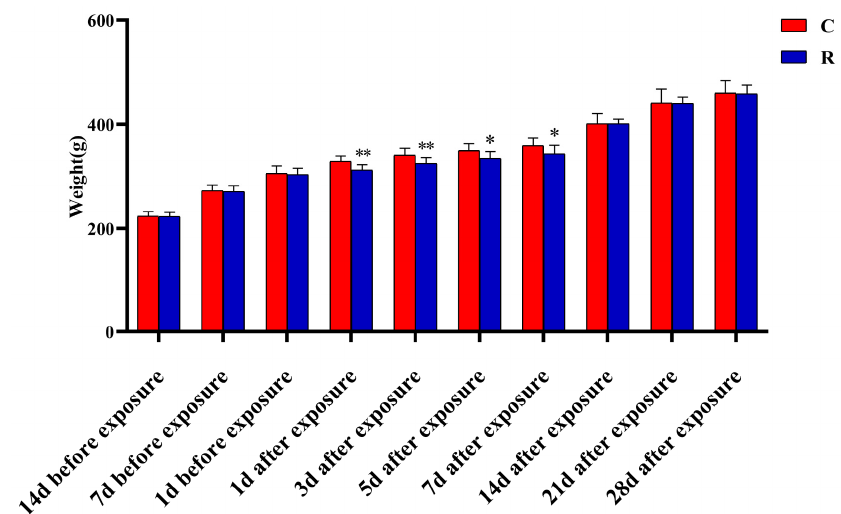
Figure 8. Weight changes in rats before and after S-band radiation. Significance signs were classified according to p -value: * p < 0.05 and ** p < 0.01.